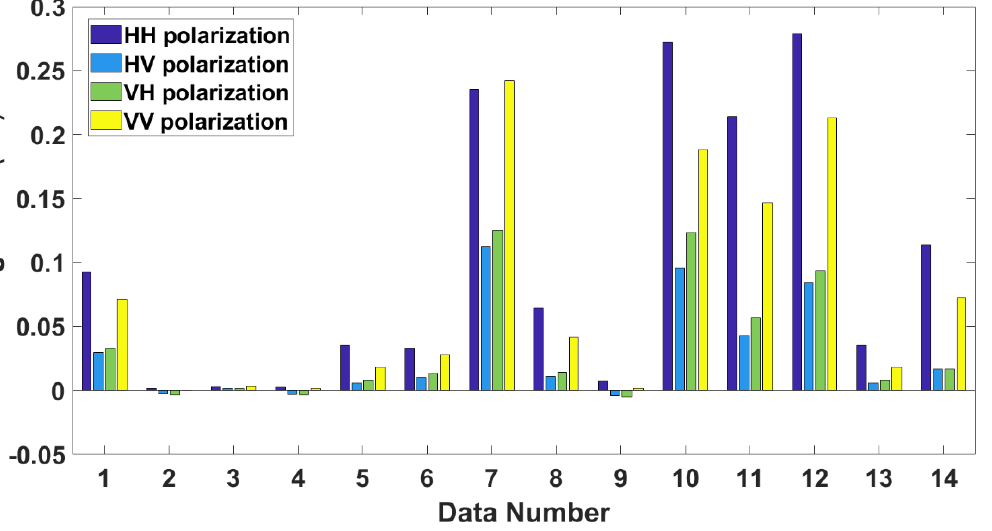
Figure 2. Average signal–clutter ratio (SCR) of 14 sets of echo data.